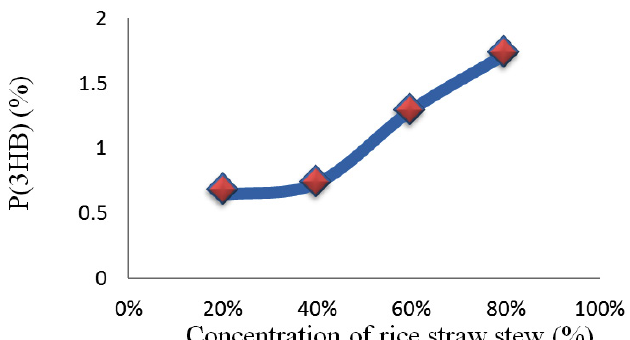
Fig. 1. The relationship between the percentage of P(3HB) accumulated in Psedomonas aeroginasa cells versus concentration rice straw stew used